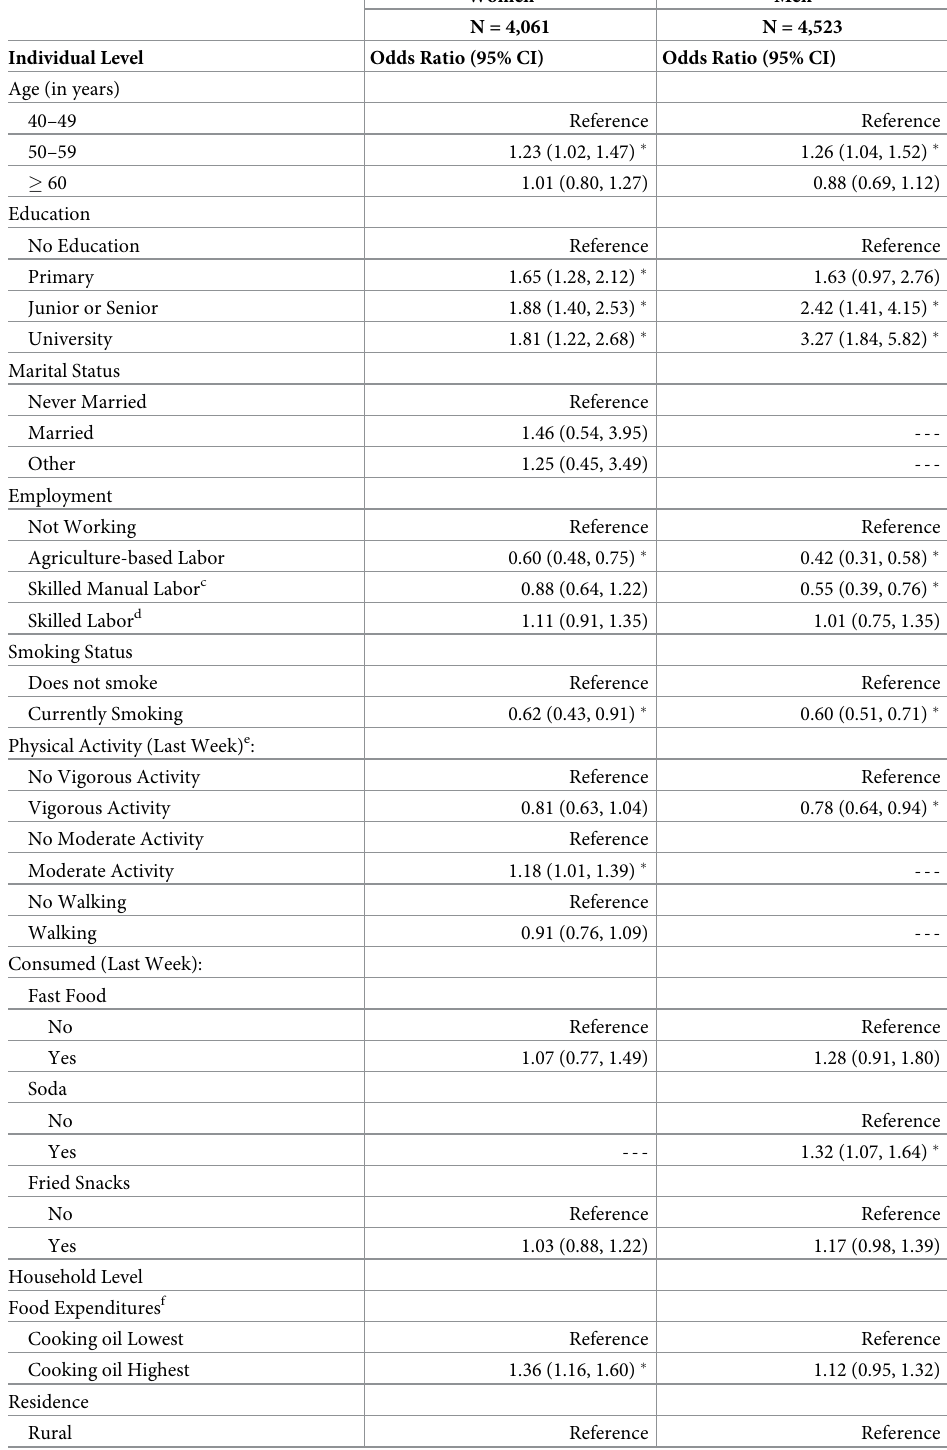
Table 4. Multivariable Logistic Regression Testing the association between selected characteristics and central obesity among adults in Indonesia,